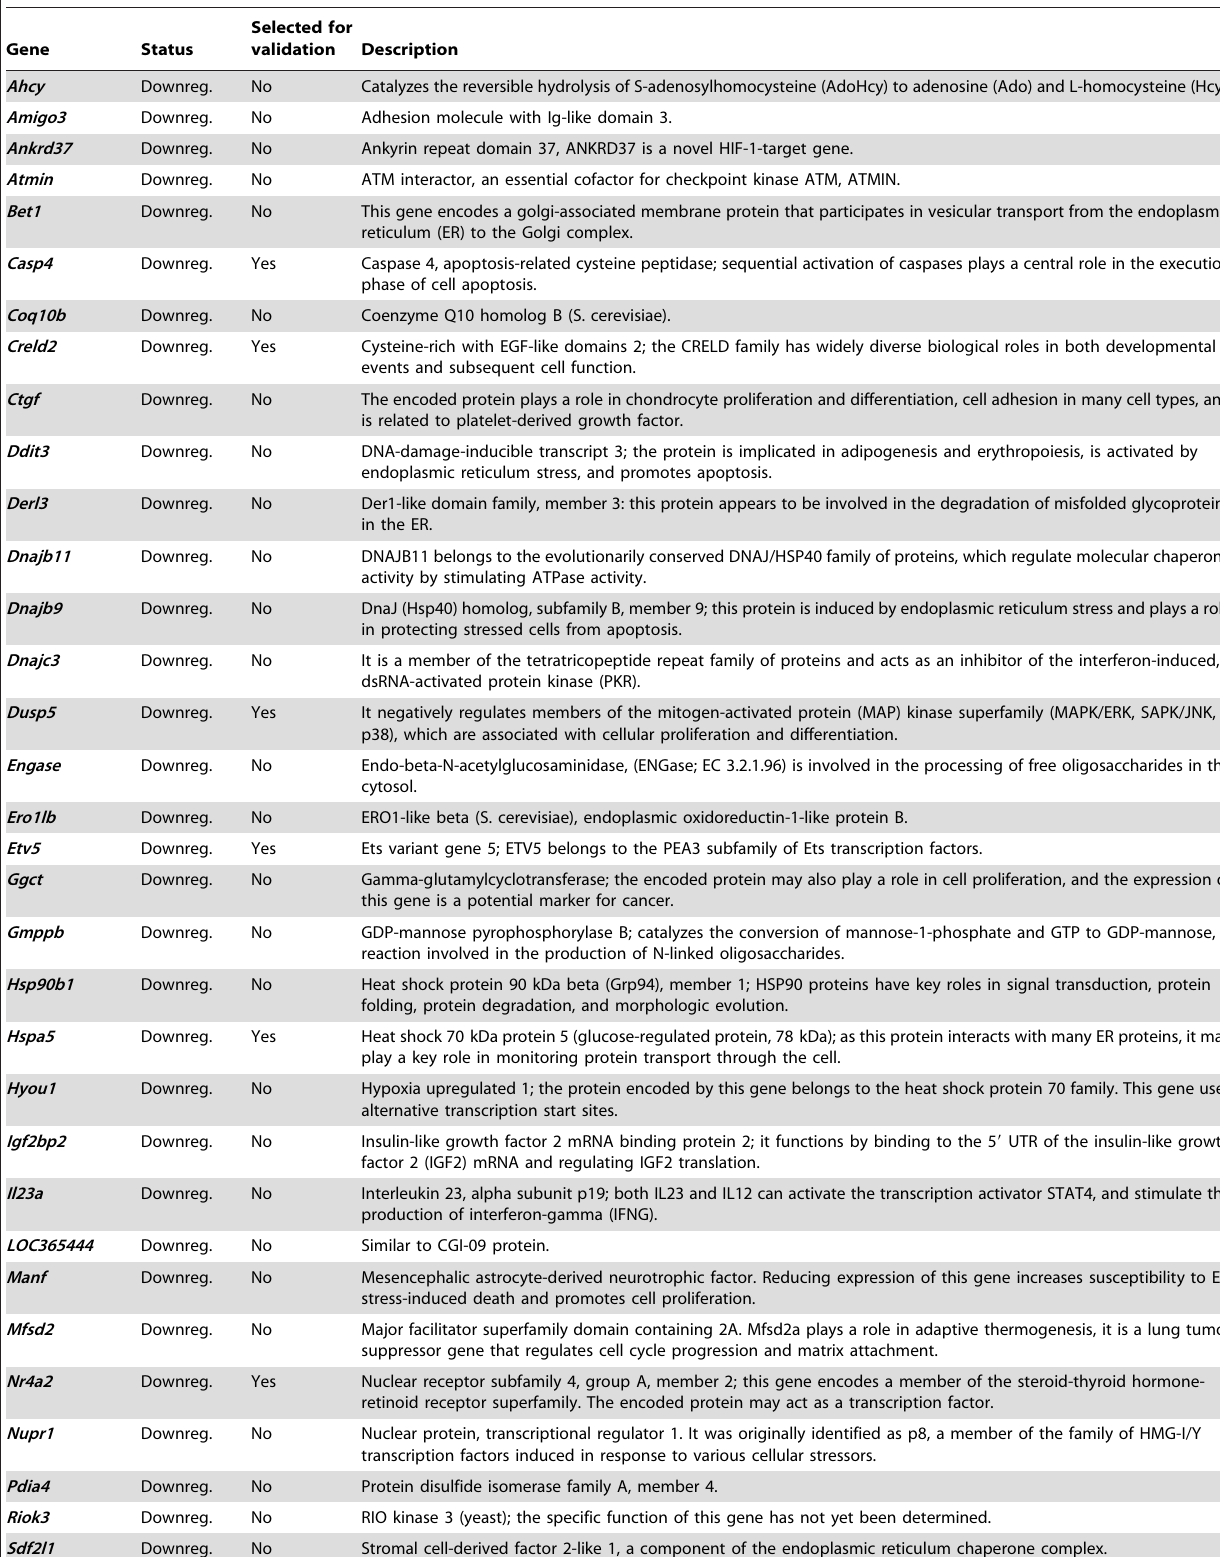
Table 2. Description of statistically genes significantly (p , 0.005) regulated by FoxE1.